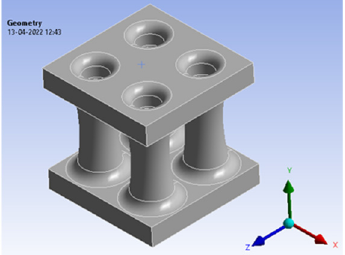
Figure 10. Bambusa tulda model isometric view.